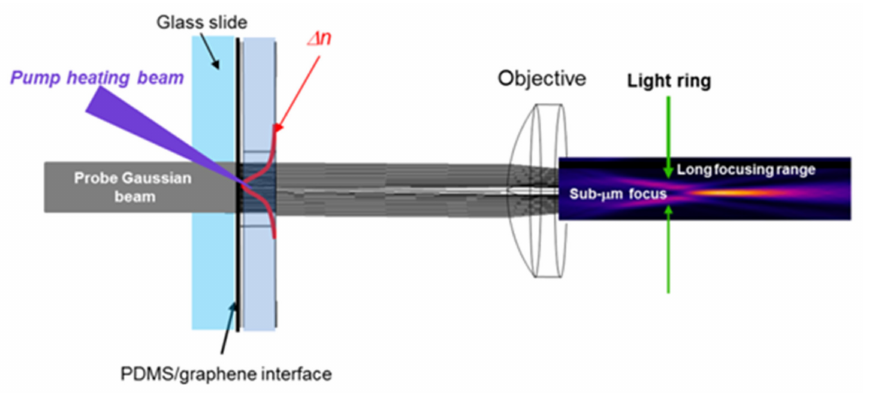
Figure 1. Working principle of the PDMS/SLG thermo-optical device. The absorbed pump heats up the PDMS locally, creating a refractive index profile ∆ n characteristic of a negative axicon. The input beam is focused into a light ring by an objective. The successive propagation produces the sub-micrometric